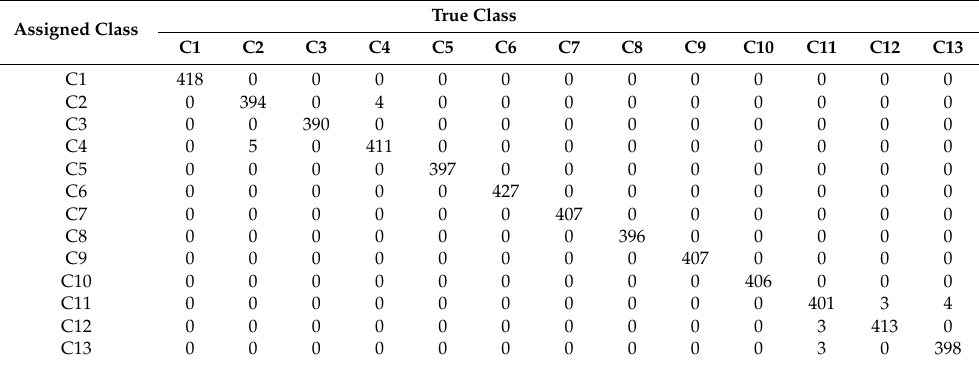
Table 3. Confusion matrix of PQD